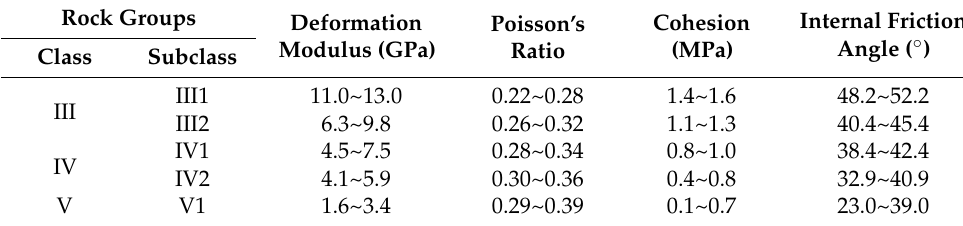
Table 1. Reference intervals for back analysis of mechanical parameters.